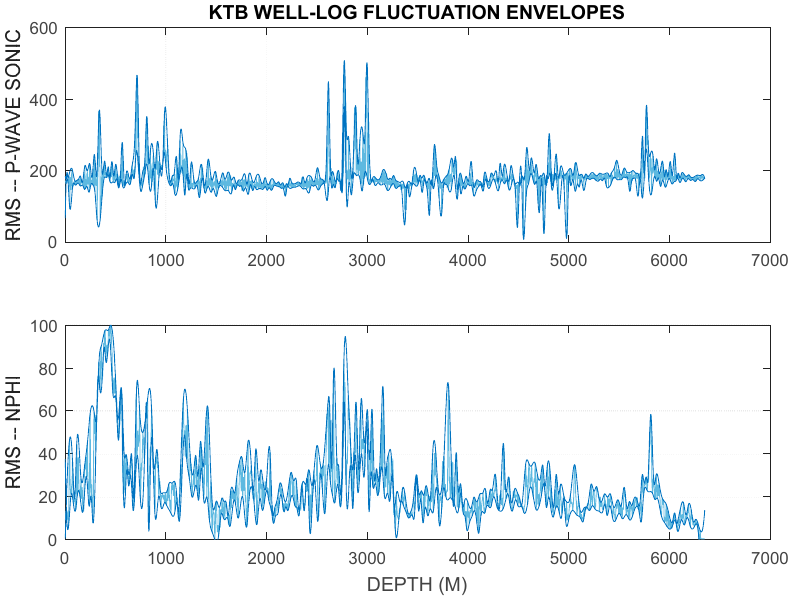
Figure 21. KTB well-log fluctuation amplitude preservation to 6.5 km depth for P-wave sonic velocity ( Upper panel) and neutron porosity ( Lower panel) [24].